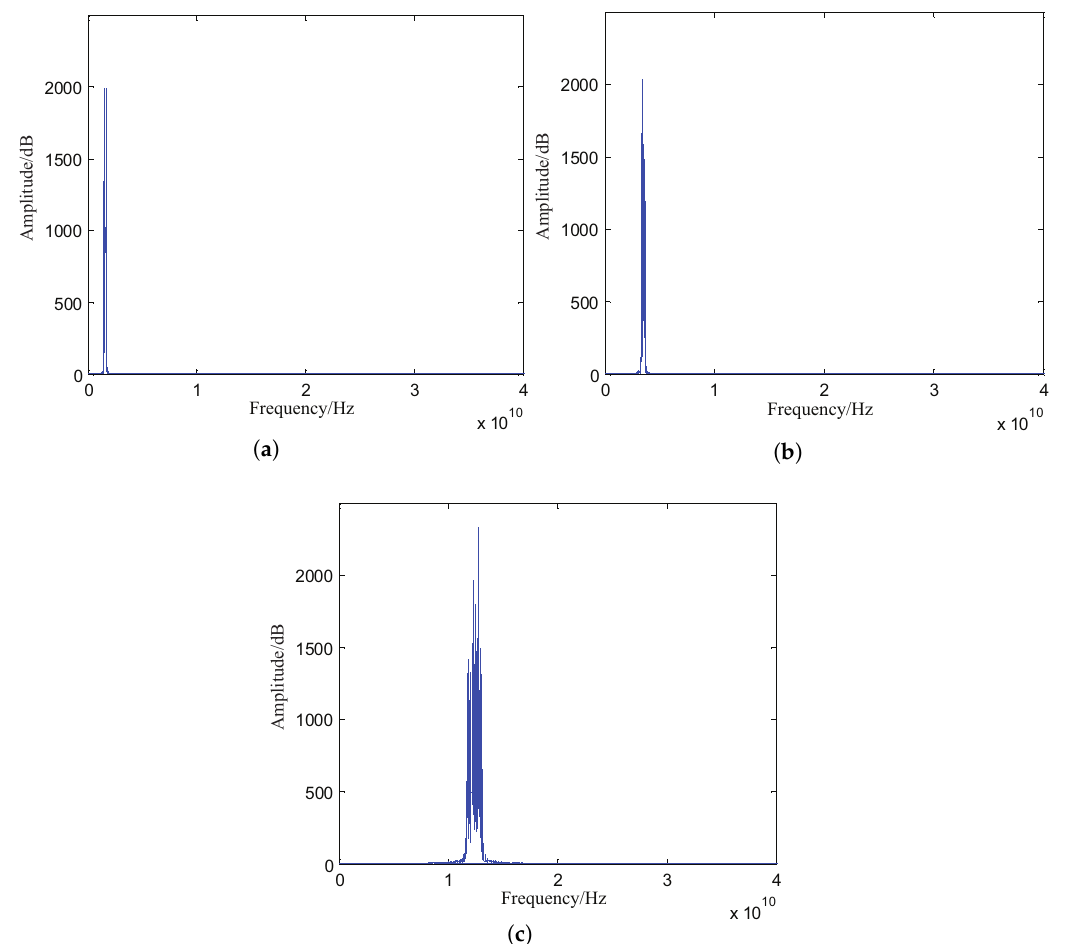
Figure 3. Spectrograms of three time-domain overlapped satellite signals after separation. ( a ) Spectrogram of GPS satellite signal; ( b ) Spectrogram of INMARSAT satellite signal; ( c ) Spectrogram of DVB-S satellite signal.